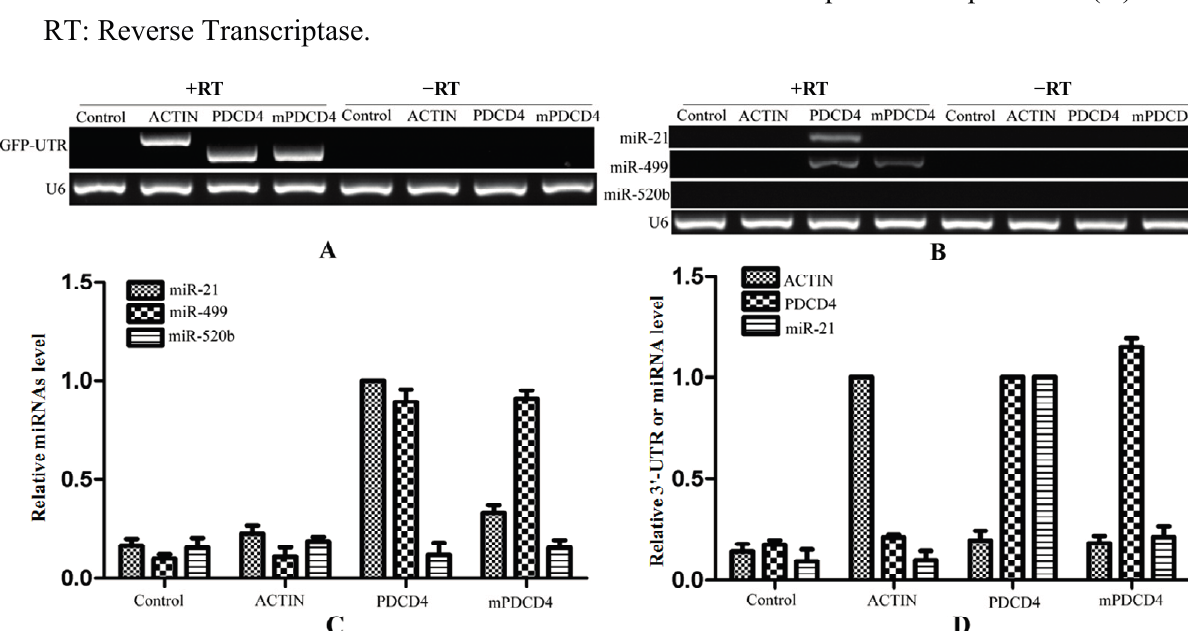
Figure 5. Validation of miRNAs targeting to single mRNA isolation technique. The RNA in the products of pull-down were reverse transcripted and as templates for